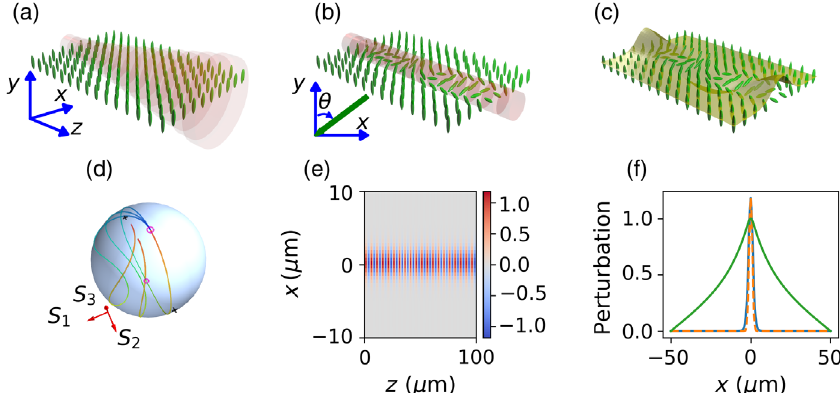
FIG. 1. Schematic of light propagation through a homeotropically aligned LC material. (a) Diffraction of a low-power Gaussian beam propagating through the LC medium. (b) Confinement of a high-power Gaussian beam due to the periodic modulation of the LC molecule. The inset shows the angle θ , which is equal to zero when the optical axis is parallel to the axis y . The modulation period is λ = Δ n . (c) In each period, the polarization evolves as in a wave plate: The Stokes parameter S 3 (yellow surface) varies from RCP (input) to LCP [ λ = ð 2 Δ n Þ ] and then back to RCP at the output. (d) Visualization on the Poincar´e sphere of the polarization dynamics of plane waves in one birefringent length. The angle of the optical axis θ is supposed to be sinusoidal along the propagation direction. The different lines correspond to a maximum rotation angle θ of 5°, 15°, and 45°, respectively (the loop is almost closed for the lowest max angles, but it opens up as the angle is increased). (e) Distribution of the rotation θ (in degrees) on the plane xz and (f) the corresponding cross section (solid blue line) versus x , taken in the section where the rotation angle is maximum; the input parameters are w ¼ 2 μ m, and the power density is 2 × 10 3 W m − 1 . The dashed line corresponds to the intensity profile I , whereas the green solid curve is the normalized to one light-induced rotation for a uniform (both intensity and polarization) excitation along z , i.e., for the case of localization based on the dynamic phase. Here, λ ¼ 1064 nm, n ¼ 1 . 7 , and n ⊥ ¼ 1 . 5 k (right circular polarization, RCP),